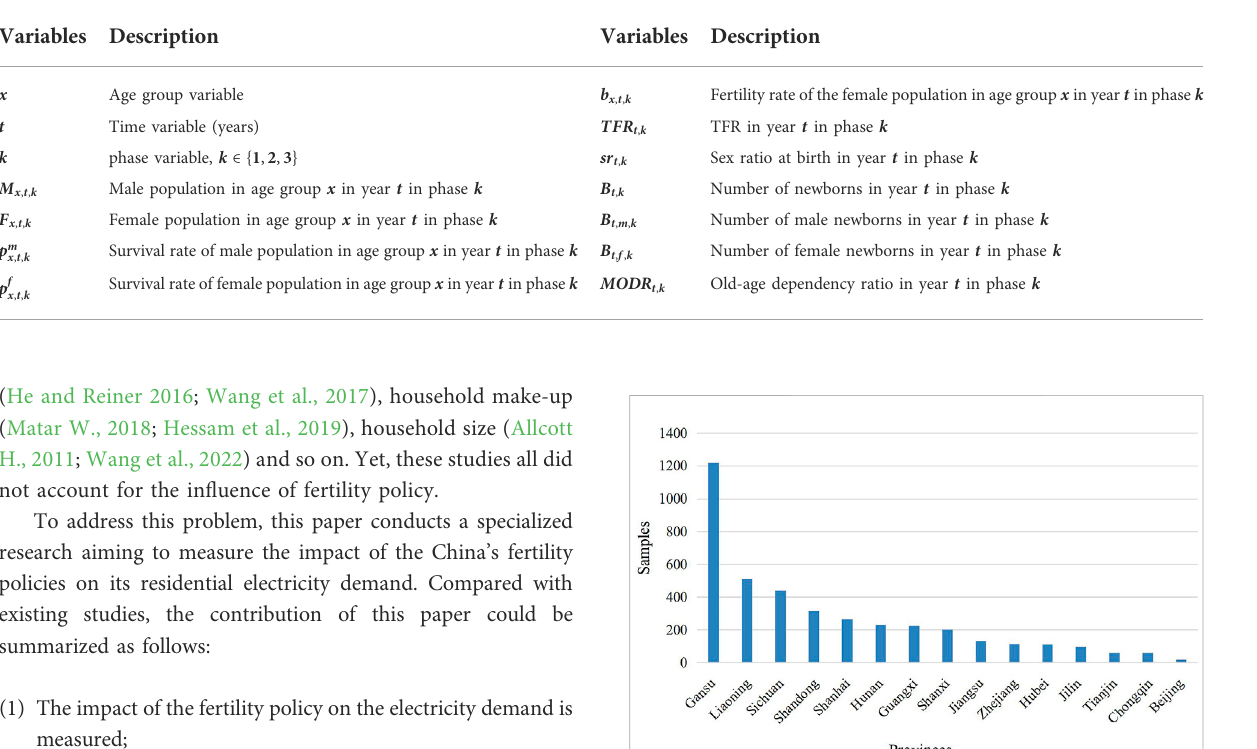
TABLE 1 Description of model variables.